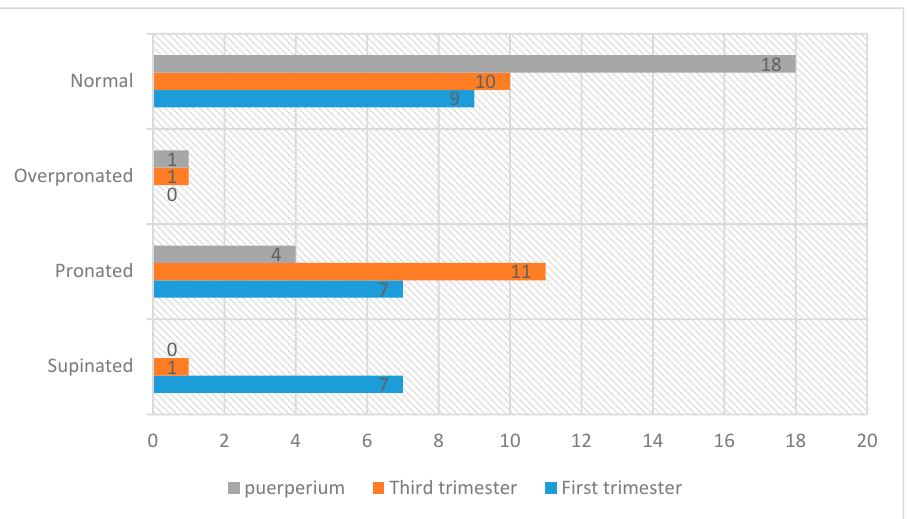
Figure 2. Changes in foot posture during pregnancy and puerperium (number of cases and type of foot posture).